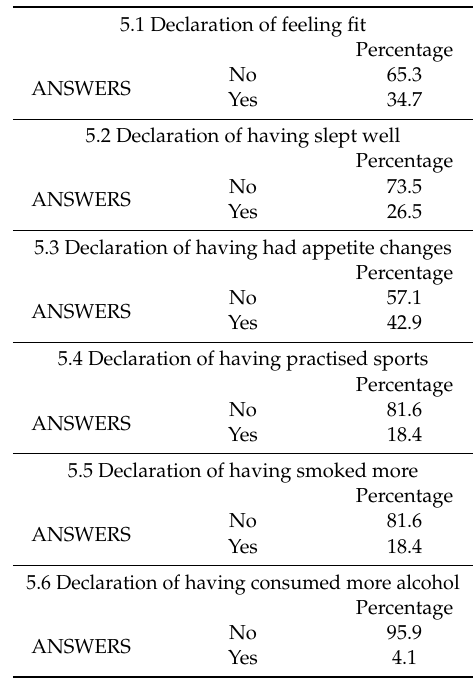
Table 5. Area 5: quality-of-life